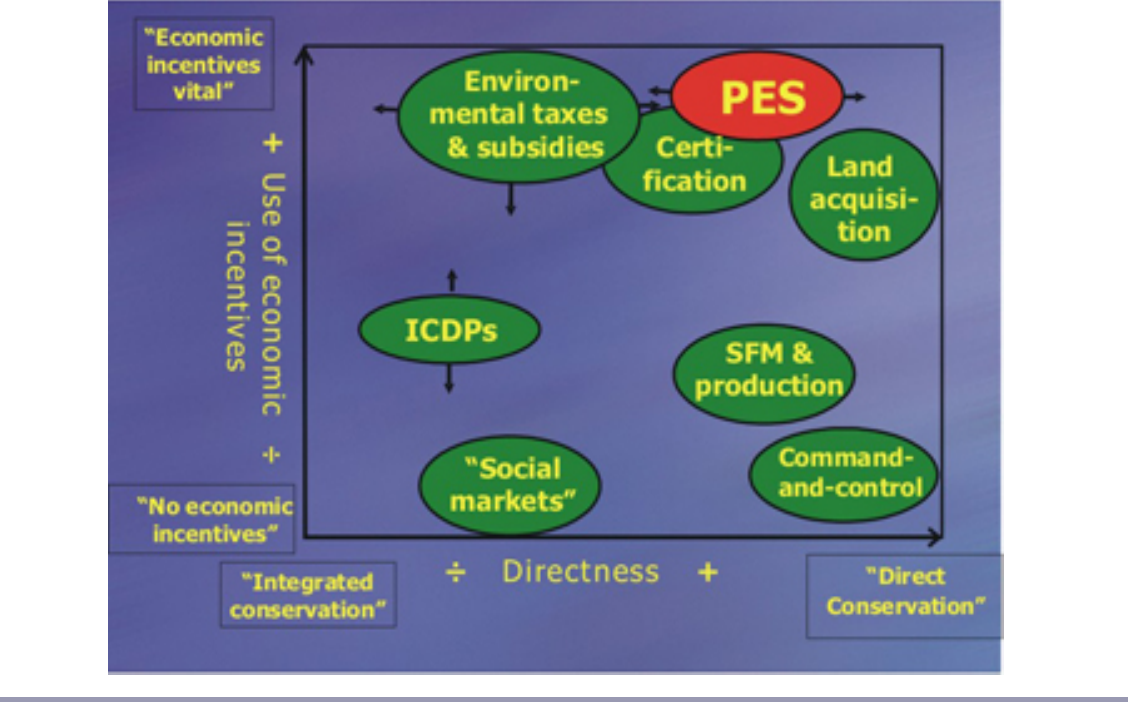
Fig. 1 . Comparing payments for environmental services (PES) to other conservation approaches. ICDP stands for integrated conservation and development project, and SFM stands for sustainable forest